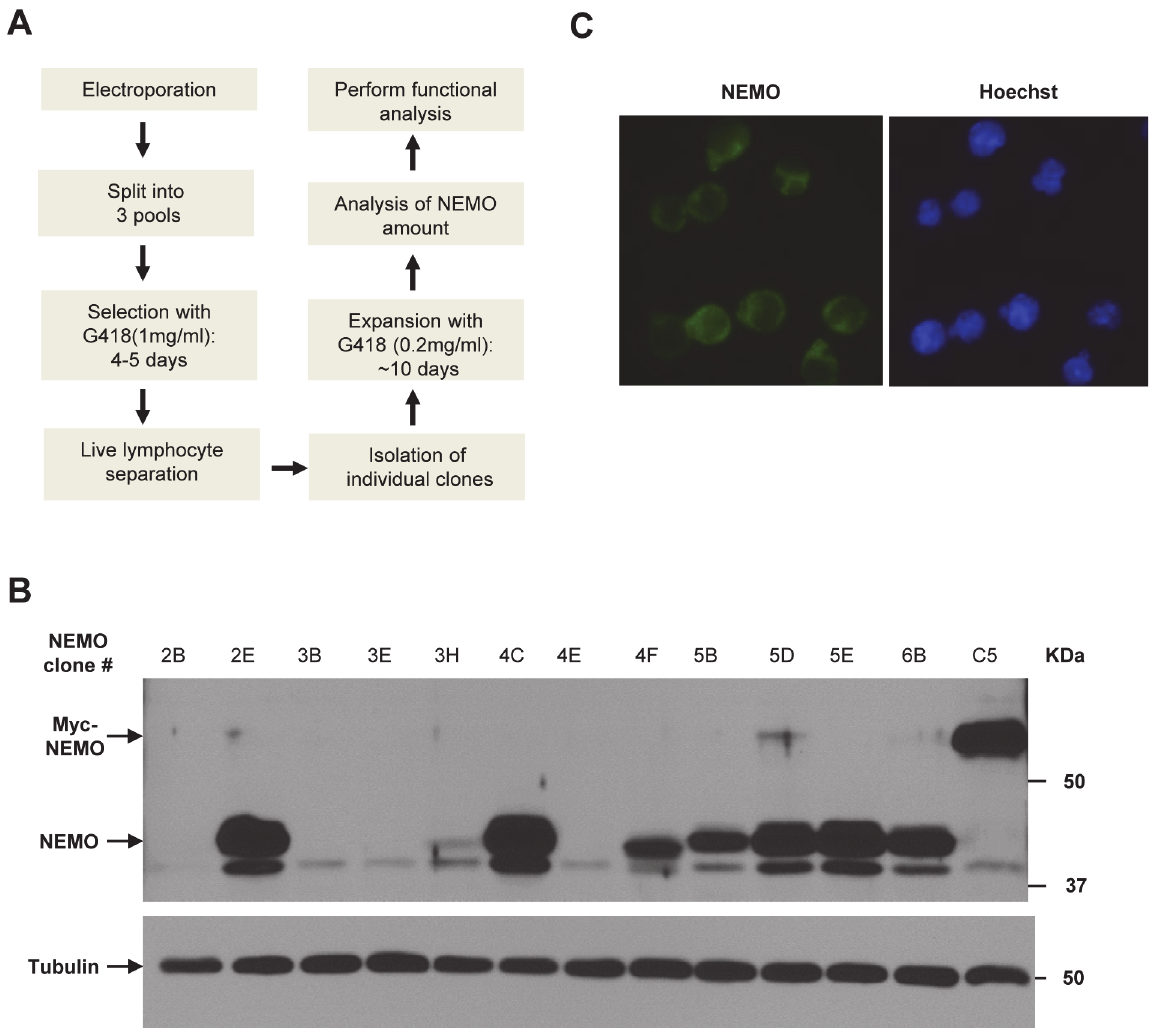
Fig 3. Generation of 1.3E2 clones expressing different amounts of NEMO protein. (A) Work flowchart to generate NEMO reconstituted 1.3E2 cell clones. (B) An example of Western blots with different NEMO stable clones. Protein extracts from different 1.3E2 clones were separated on SDS-PAGE gel and immunoblotted with NEMO antibody. Tubulin was used as a loading control. (C) An example of immunofluorescence analysis with NEMO antibody (Green) in a NEMO reconstituted 1.3E2 stable clone. Nuclei were visualized by Hoechst staining (Blue).